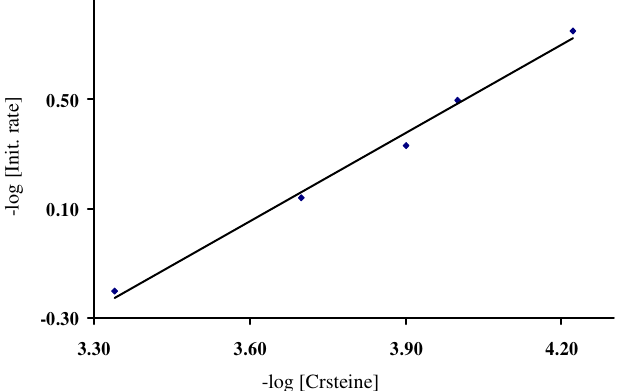
Figure 8. Plot of log [Initial rate] vs . log [Cysteine] at λ [DPKTH] = 5 x 10 -4 M, [Cysteine] = 0.6-4 x 10 -4 M, 10% ethanol and pH =